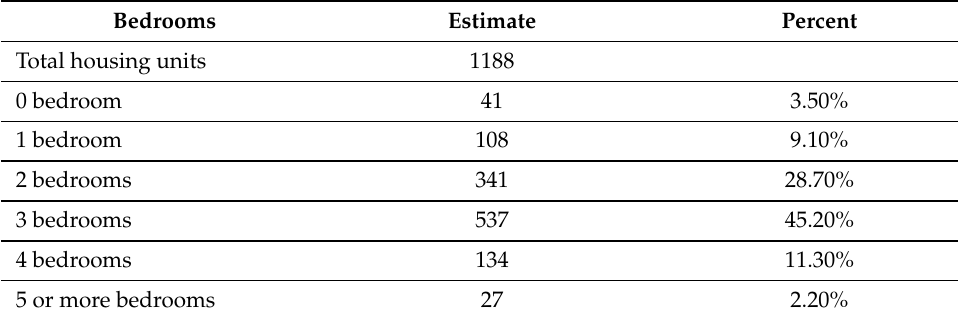
Table 3. Distribution of bedrooms in the test community